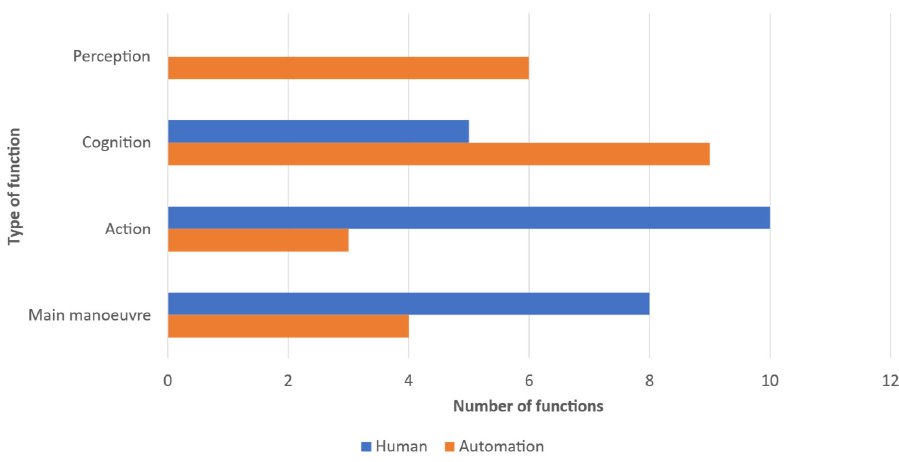
Figure 8. Comparison of the risk distribution over the types of function between humans and auto- mation.